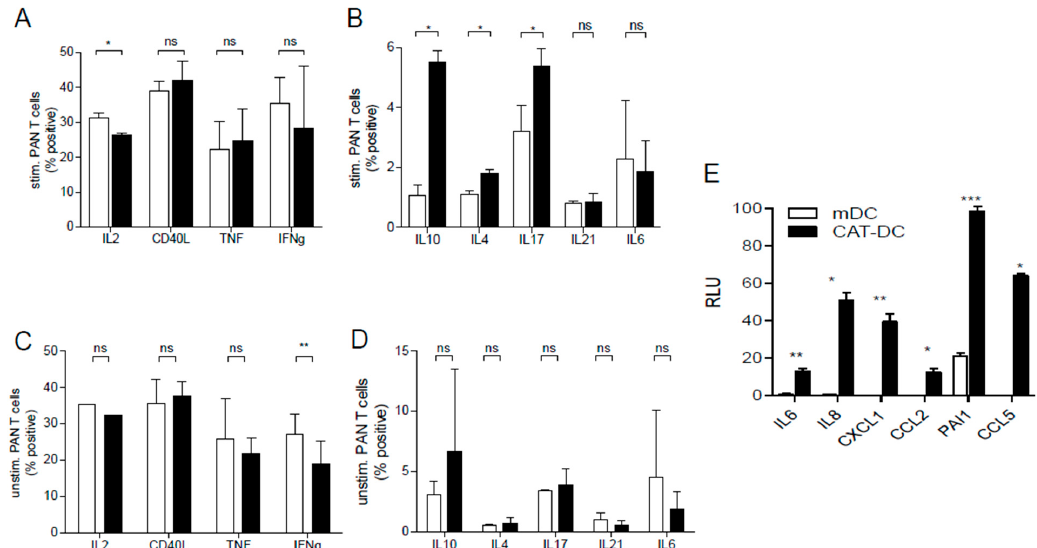
Figure 3. CAT-DCs induce changes in T-cell-polarization after 6 days of coculture and exhibit an altered cytokine profile. ( A , B ) Analysis of expression of IL2, CD40L, TNF α , IFN γ , IL10, IL4, IL17, IL21, and IL6 in PAN T-cells after 6 days of coculture with CAT-DCs in the presence of T-cell-activating CD3/28-beads ( n = 3). ( C , D ) Analysis of expression of IL2, CD40L, TNF α , IFN γ , IL10, IL4, IL17, IL21, and IL6 in PAN T-cells after 6 days of coculture with mDCs in the presence of T-cell-activating CD3/28-beads ( n = 3). Gating strategy for flow cytometric T-cell-polarization analysis and a selection of representative plots can be found in Figure S6. ( E ) Proteome profiling of CAT-DCs compared to mDCs for expression of IL6, IL8, CXCL1, CCL2, CCL5 and PAI1 ( n = 3, RLU = relative luminescent units). Statistical analysis was performed with a paired two-tail Student’s t -test. (* p < 0.05, ** p < 0.01, *** p < 0.001).